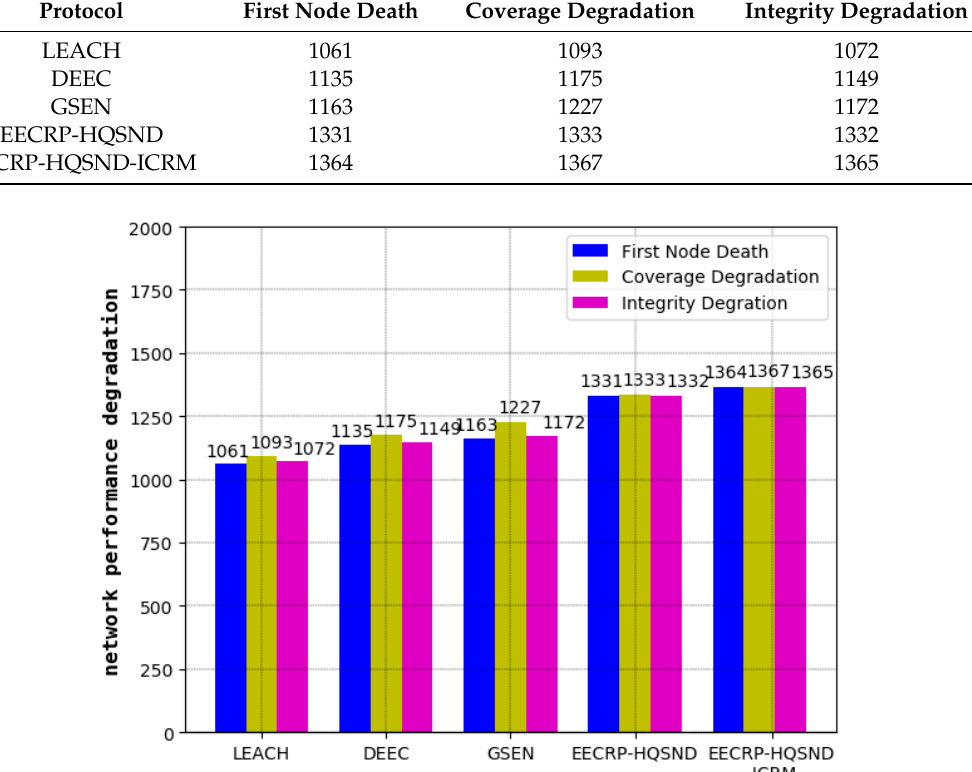
Figure 18. Comparison of the number of rounds leading to decline in the network for each protocol.